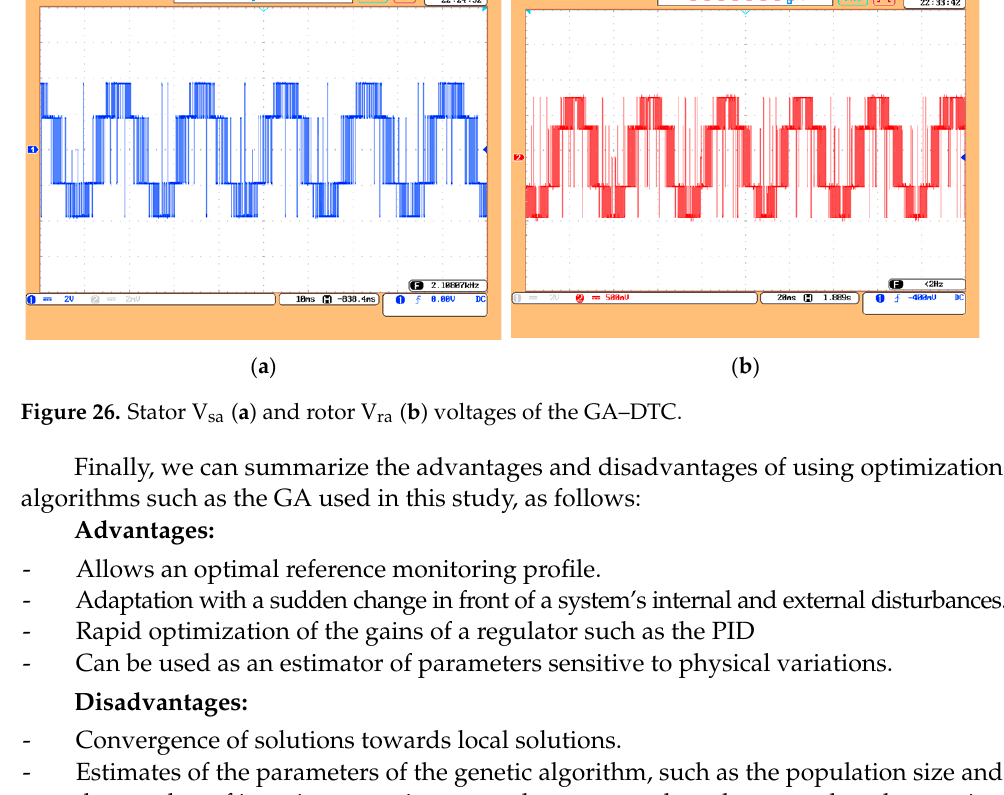
Figure 25. Inverter control pulses of the stator ( a ) and rotor ( b ) of the GA–DTC.